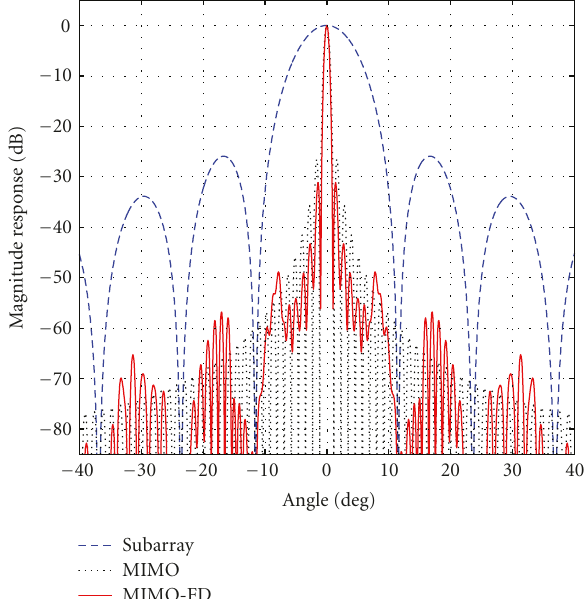
Figure 9: Beam pattern for MIMO and MIMO-FD arrays with the sparse distance L = 100 λ 0 / 2.